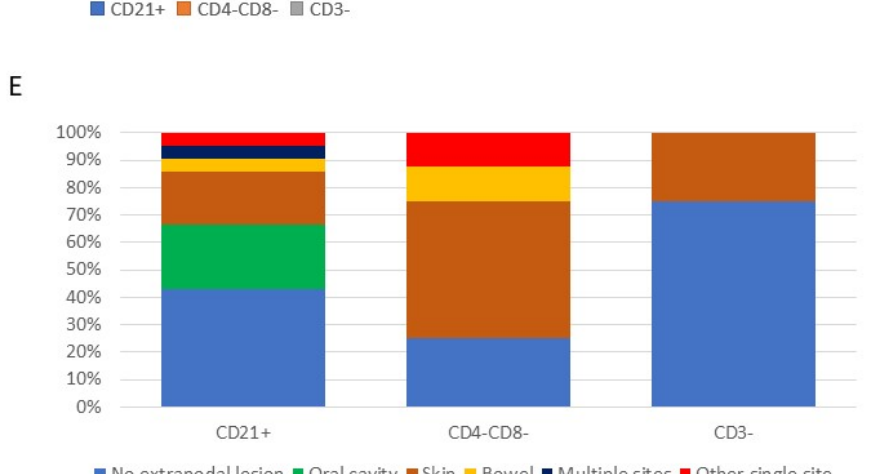
Figure 2. Breed ( A ), sex ( B ), age ( C ), substage ( D ), and presence of extranodal lesions ( E ) in 101 dogs with T-zone lymphoma, according to the three most common phenotypic aberrancies.